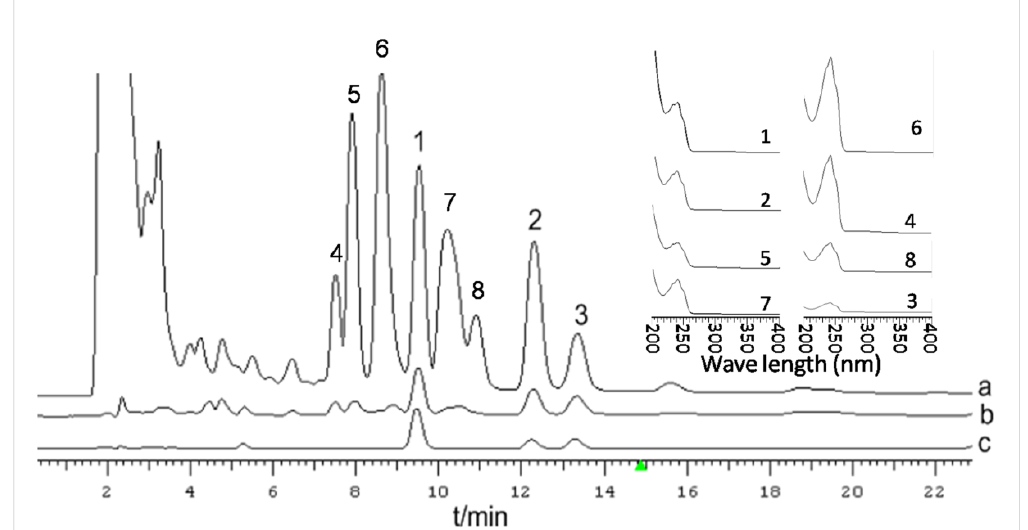
Figure 6. HPLC chromatograms of cultured P. cocos mycelia sampled on the 17th day ( a ), cultivated P. cocos sclerotium ( b ) and the three standard triterpenoid compounds ( c ). The inset shows the UV spectra of HPLC peaks 1–8. 1, dehydrotumulosic acid (DTA); 2, polyporenic acid C (PAC); 3, 3-epi-dehydrotumulosic acid (eDTA); 4–8 unknown triterpenoids.